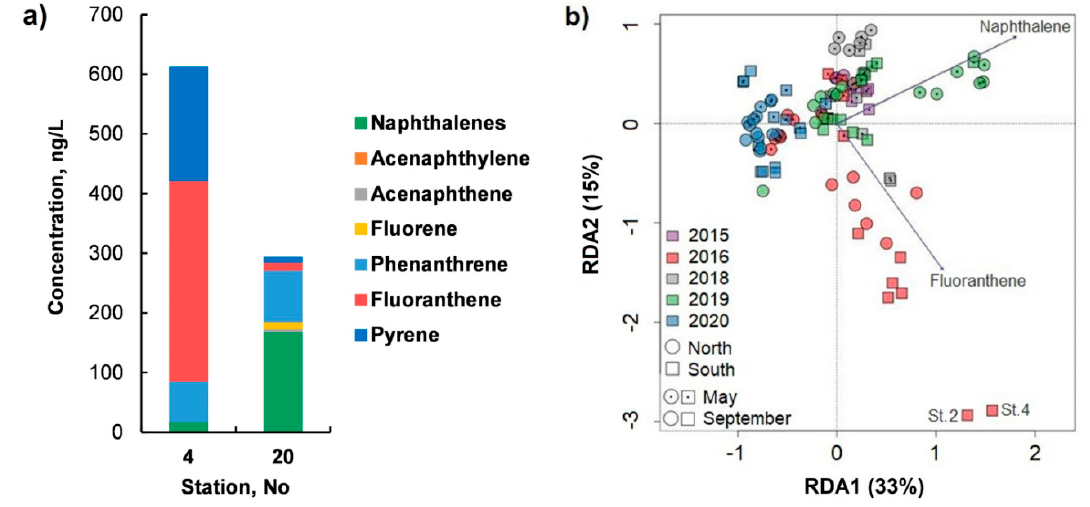
—southern basin, Figure 2. PAH concentrations in water from the pelagic zone of Lake Baikal : ( a ) Box plot of the Ʃ PAHs concentrations; ( b ) .